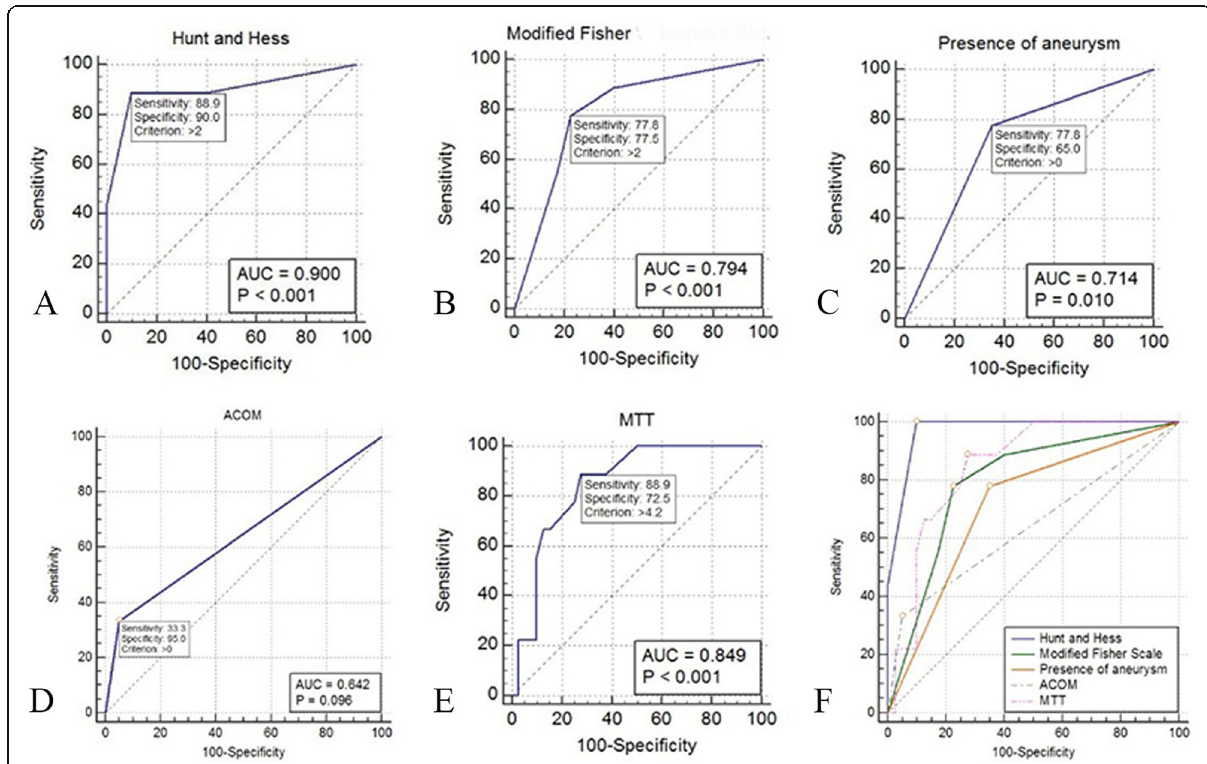
Fig. 2 ROC curves of the studied predictors. a Hunt and Hess scale, b modified Fisher scale, c presence of an aneurysm, d ACOM aneurysm, e MTT, and f comparison of variables shows that Hunt and Hess scale has the optimal sensitivity and specificity. ACOM , anterior communicating artery; MTT , mean transit time